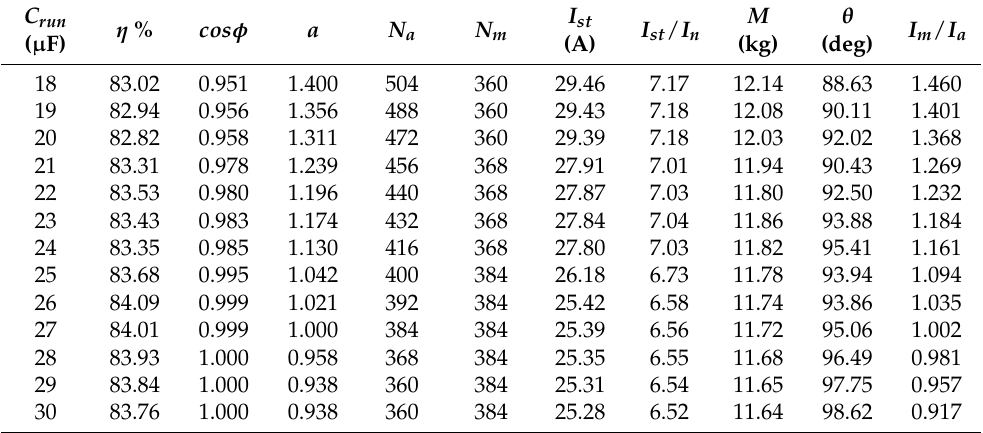
Table 3. Design parameters and performance quantities of the SPIMs with rotor bars of trapezoidal shape.